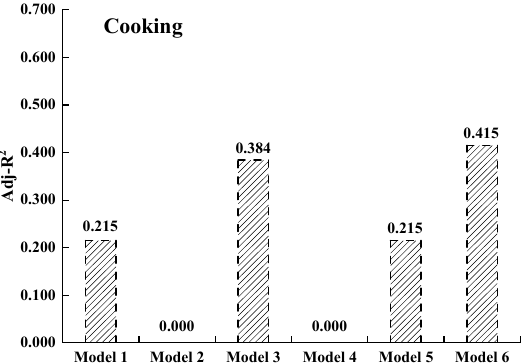
Table 10. Analysis results of valid determinants for cooking. Figure 9. The Adj-R 2 of six cooking energy consumption